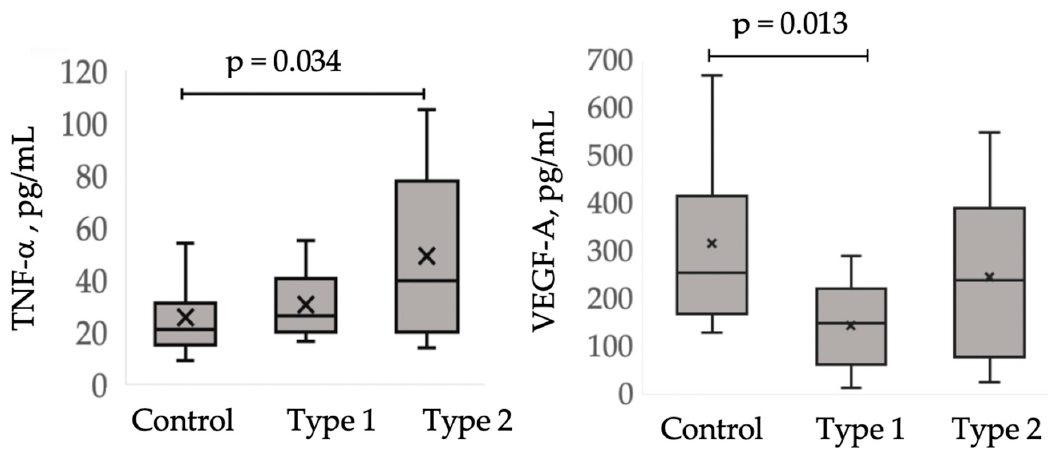
Figure 3. Comparative analysis of vascular endothelial growth factor-A (VEGF-A) and tumor necrosis factor- α (TNF- α ) levels between patients with MRI type 1 and MRI type 2 and the controls. Correlations were established between the levels of TNF- α and TGF- β 1 ( r = 0.378, p = 0.000), TNF- α and HIF-1 α ( r = 0.220, p = 0.035), and VEGF-A and HIF-1 α ( r = 0.237, p = 0.023).